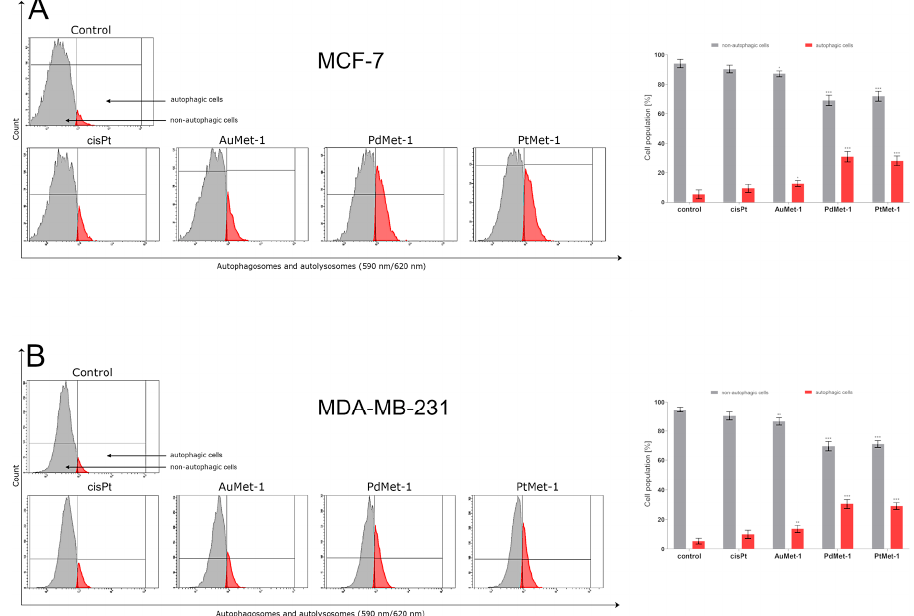
Figure 5. Autophagy induction in MCF-7 ( A ) and MDA-MB-231 ( B ) breast cancer cells measured by flow cytometry using Autophagy Probe (right-red histogram) compared to negative control cells (left- gray histogram) after 24-h incubation with AuMet-1, PdMet-1, PtMet-1 and cisplatin (50 µM). Mean percentage values from 3 independent experiments (n = 3) done in duplicate are presented. * p < 0.05 vs. control group, ** p < 0.01 vs. control group, *** p < 0.001 vs. control group.